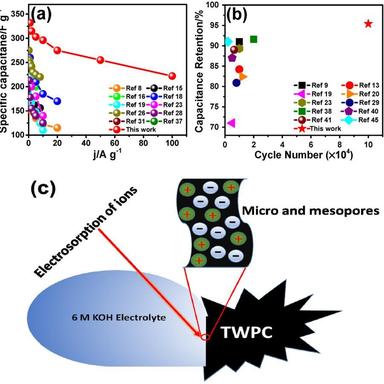
(a) Comparison of the specific capacitance of TWPC electrode with previously published biomass carbon electrodes at various CDs; (b) comparison of the long cyclic life of TWPC electrode with previously published biomass carbon electrodes and (c) working mechanism of TWPC electrode for the charge storages in supercapacitors.